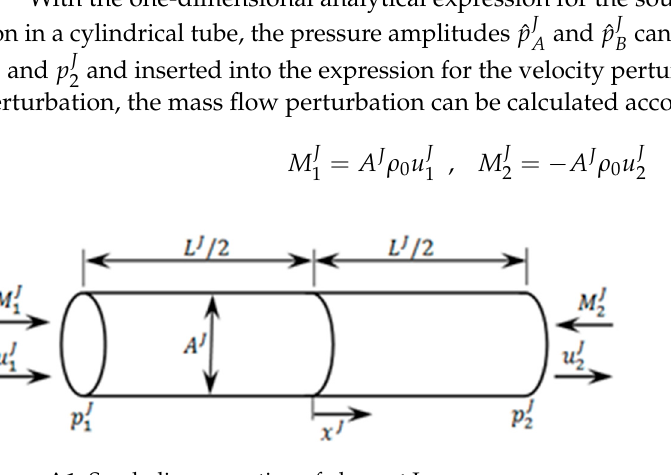
Figure A1. Symbolic convention of element Figure A1 . Symbolic convention of element J .